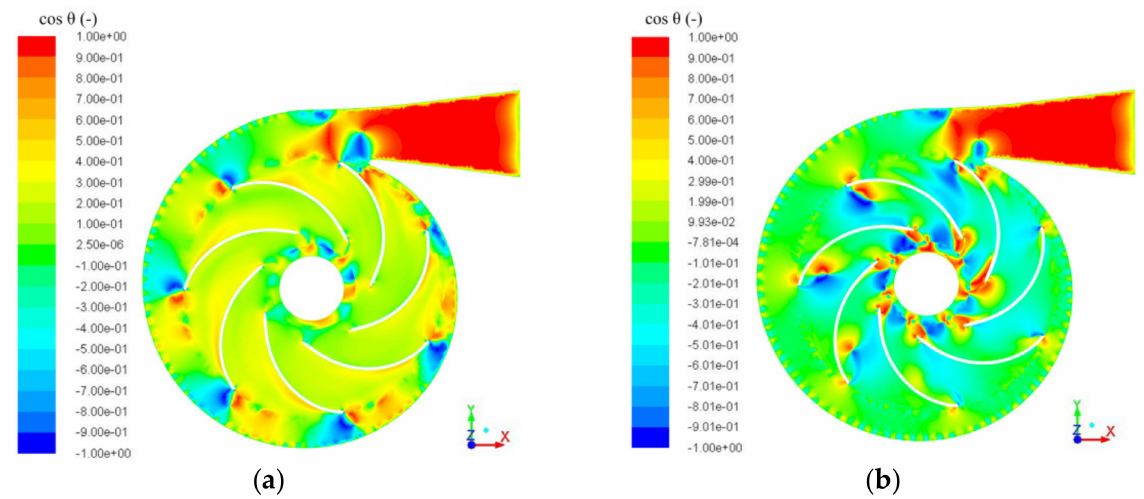
Figure 10. The synergy degree of the PAT mid-plane under different flow rates: ( a ) Q = 17.25 kg/s; ( b ) Q = 27.6